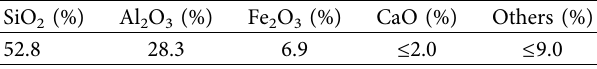
Table 4: Chemical components of fy